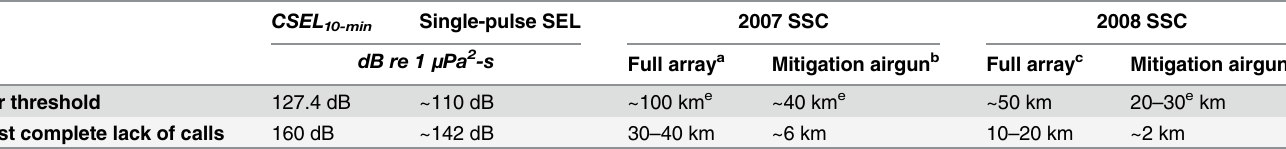
Table 6. Distances from the M/V Gilavar at which various threshold levels are reached. This table uses empirical data collected during sound source characterizations (SSCs) in the same study area in 2007 and 2008 [36, 31]. Note that regressions for sound exposure levels were not included in the reports, so the distances in this table are estimated visually from data plotted in the listed figures. CSEL = cumulative sound exposure level, SEL = sound exposure level.